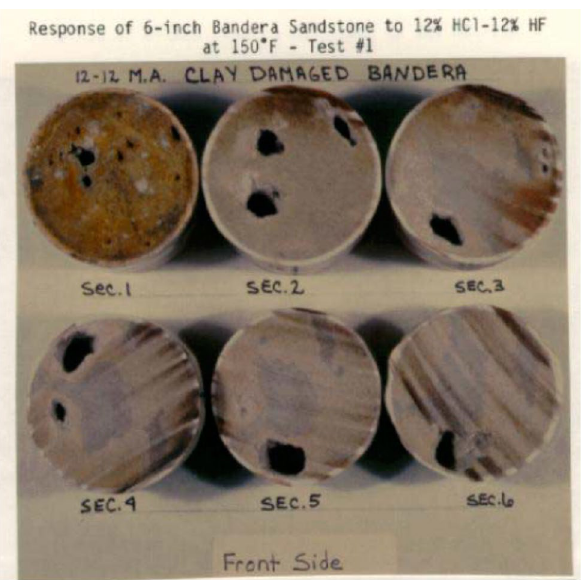
Fig. 4 Wormholes in Bandera sandstone by Lamb (1998)